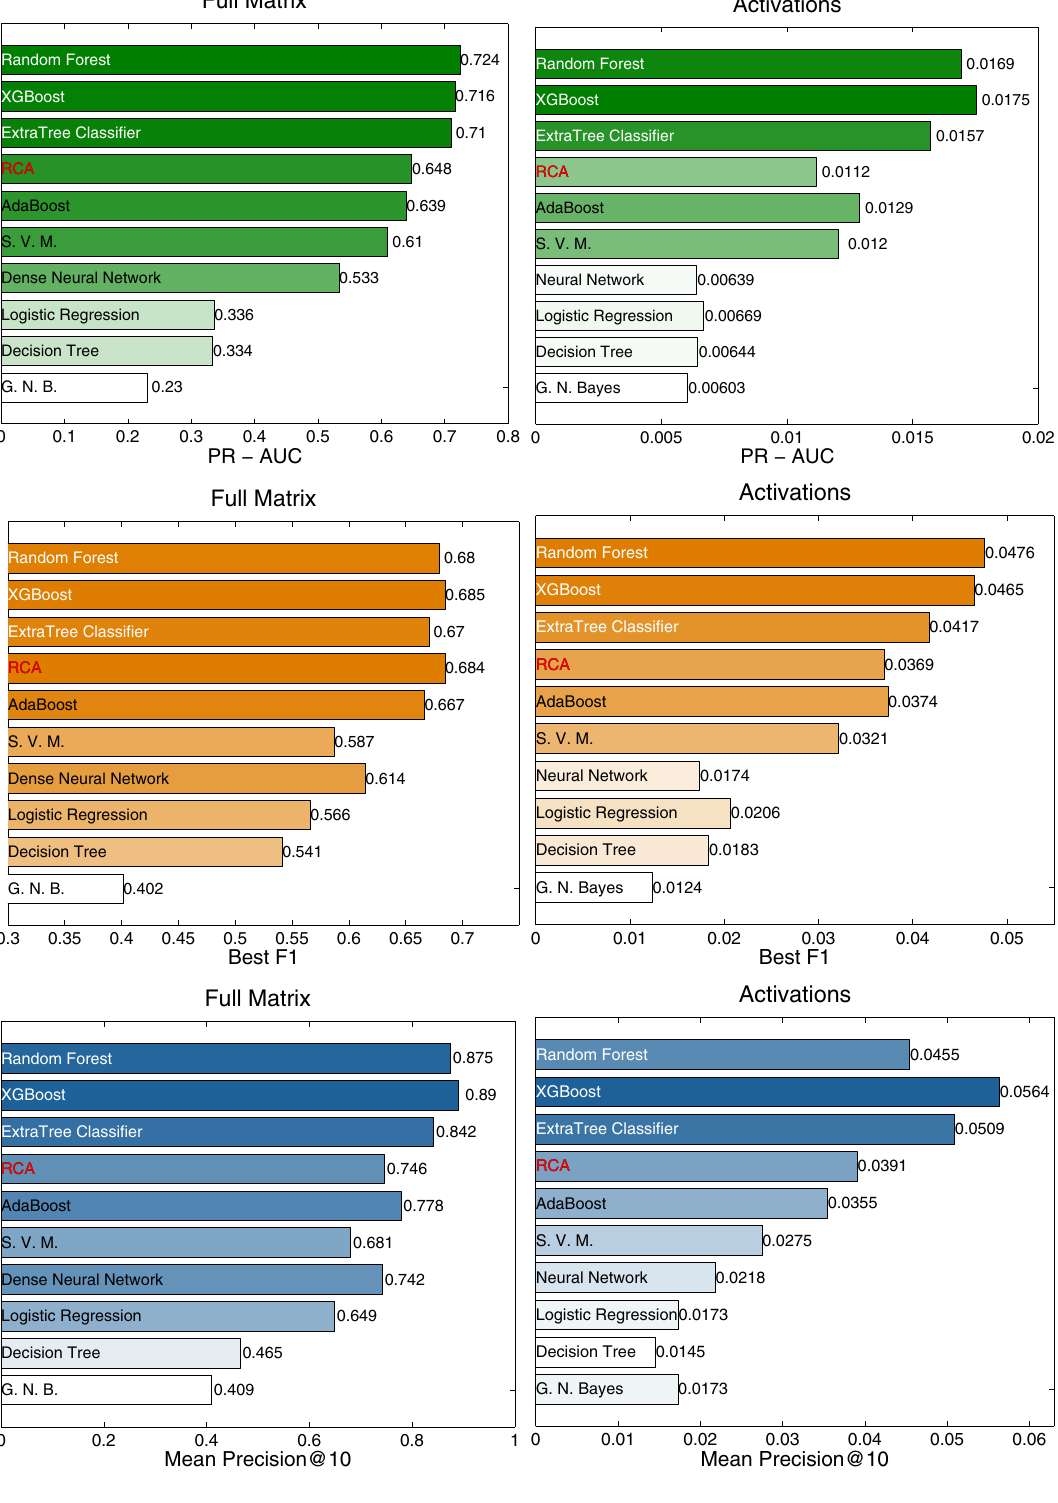
Figure 3. Comparison of the prediction performance of different algorithms using three performance indicators. Tree-based approaches are performing better; the prediction of the activations is a harder task with respect to the simple future presence of a